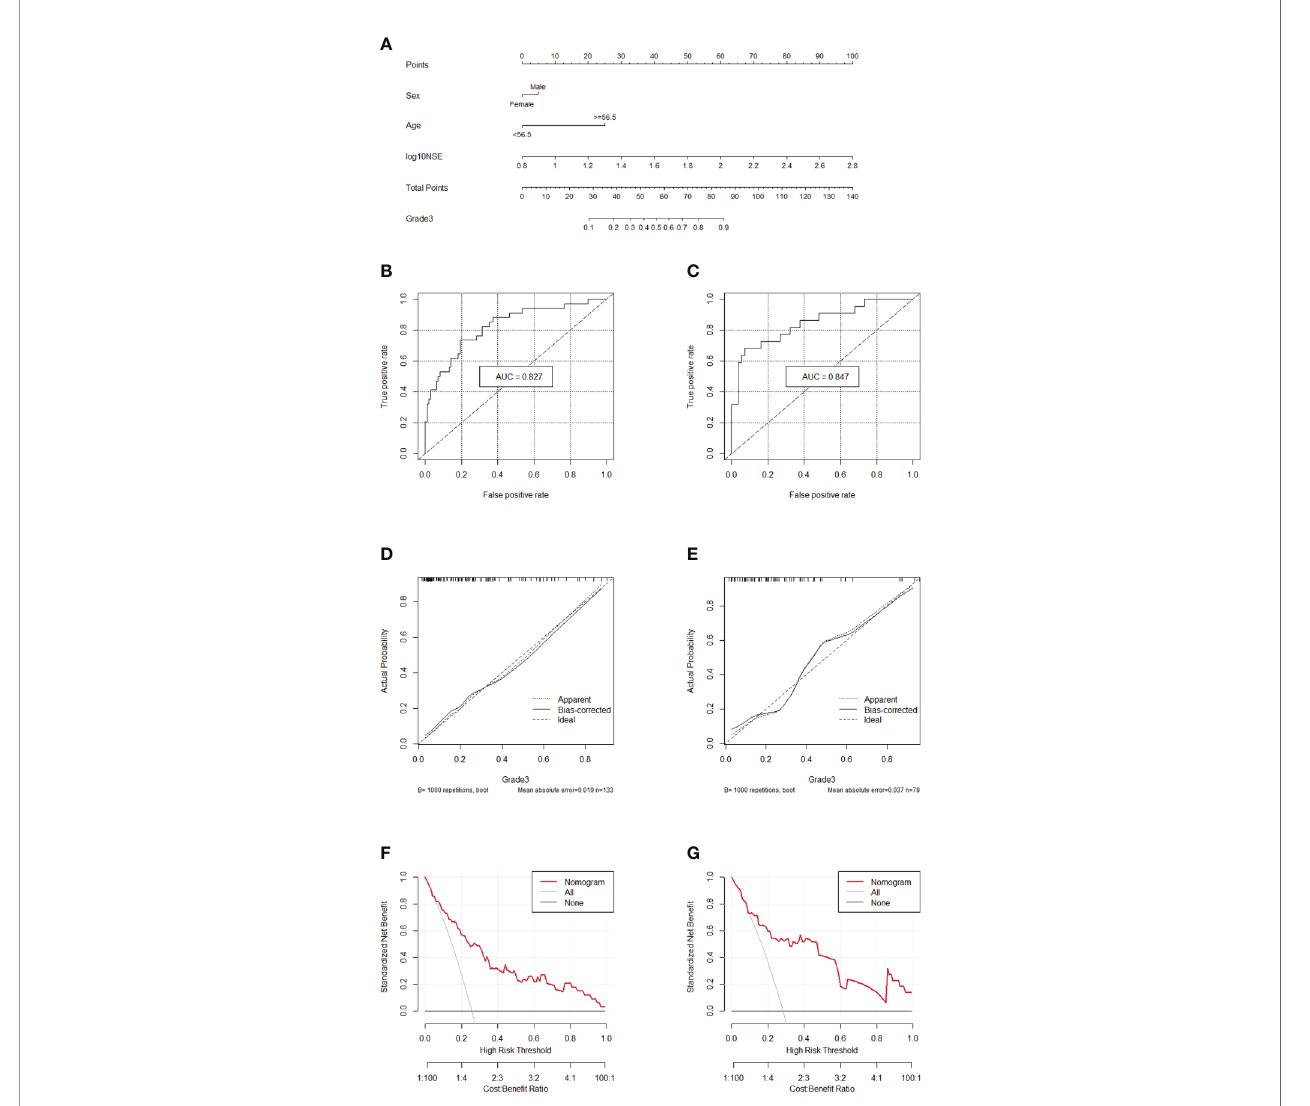
FIGURE 3 | Nomogram for preoperatively predicting of G3 risk and its predictive performance. (A) , Nomogram to estimate the risk of G3 preoperatively in patients with GEP-NETs. The area under the ROC curve (training datset: (B) ; validation dataset: (C) , the calibration curve (training datset: (D) ; validation dataset: (E) and decision curve [trainingdata set: (F) ; validation dataset: (G) ] of the